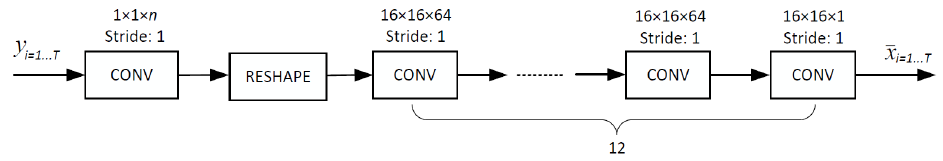
Figure 3. Spatial DCNN for initial recovery. Each intermediate reconstruction x i = 1 ... T is recovered from corresponding measurements y i = 1 ... T through its corresponding spatial DCNN.